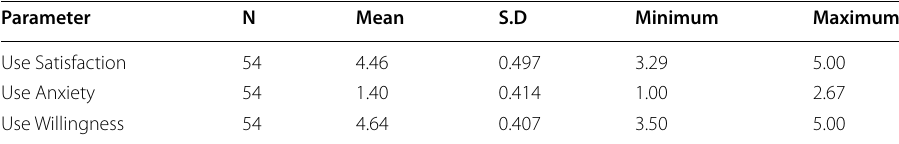
Table 5 Descriptive Statistics of Attitudes towards AR applications Parameter